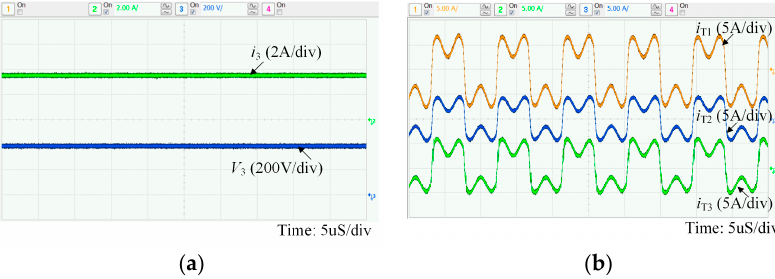
Figure 11. Experimental results of MR-TP-BDC under forward rated condition: ( a ) output voltage and current of port 3; ( b ) resonant currents of three ports.